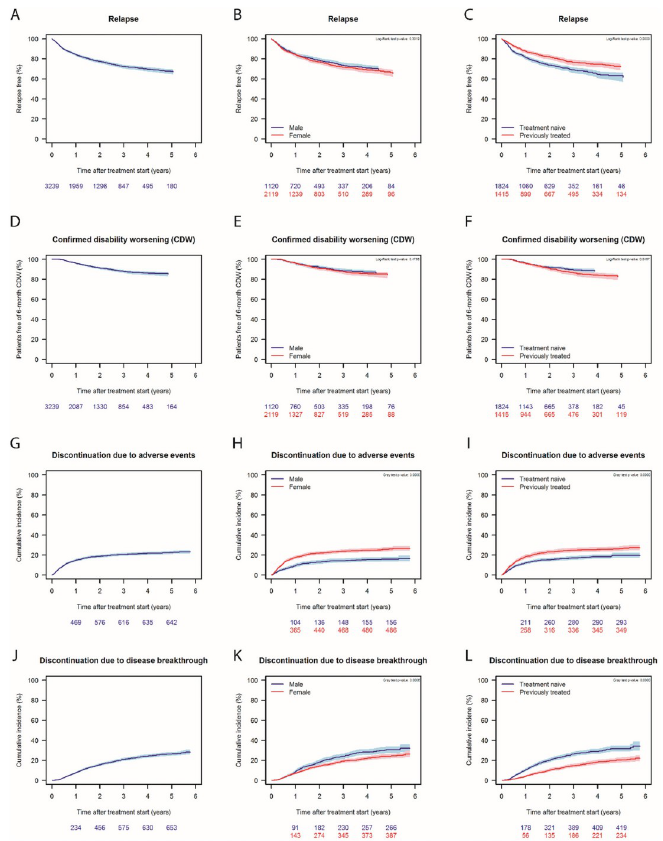
Fig 2. Long-term follow-up of patient started on teriflunomide between 2013 and 2019. Percentage of relapse-free patients in the whole cohort (A) during the follow-up, stratified by sex (B) and history of previous treatment (C). Percentage of patients free of 6-months confirmed disability worsening (CWD) in the whole cohort (D) during the follow-up, stratified by sex (E) and history of previous treatment (F). There were no male patients registered with relapse or CDW after 4.5 years, therefore the curves are shorter for males than females in B and E. Cumulative incidence of discontinuation due to adverse events in the whole cohort (G), stratified by sex (H) and history of previous treatment (I). Cumulative incidence of discontinuation due to disease breakthrough in the whole cohort (J), stratified by sex (K) and history of previous treatment (L).